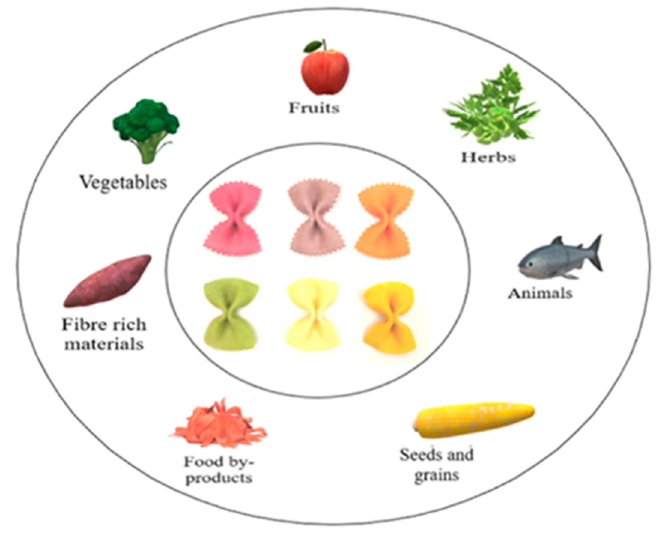
Figure 1. Current trends in pasta